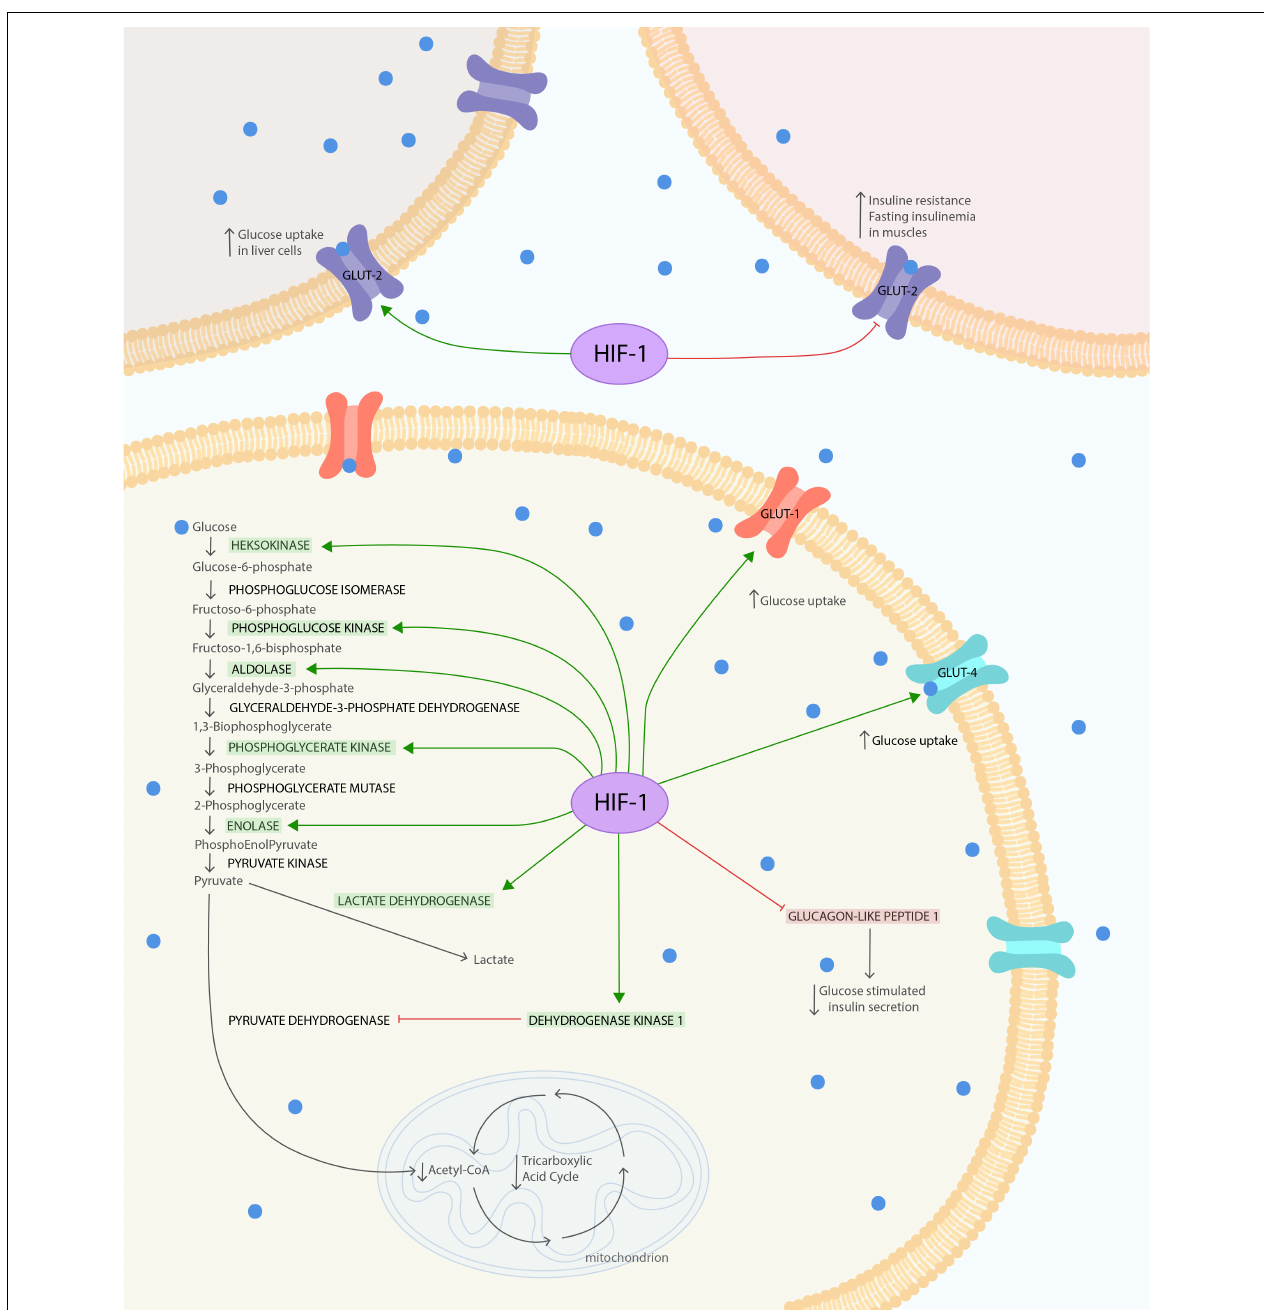
FIGURE 1 | HIF-1 α influence on glucose metabolism and insulin resistance. The HIF is composed of both oxygen-regulated α -subunit and constitutively expressed β -subunit. HIF-1 α protein is highly unstable under normoxia condition. Hypoxia leads to stabilization of HIF-1 α . HIF-1 α under hypoxic conditions causes several changes in glucose metabolism. It increases glucose uptake via glucose transporters GLUT-1 and GLUT-4 to cells. In the cell, glucose is used in glycolysis, which is also enhanced due to the modulated expression of glycolytic enzymes: phosphoglycerate kinase-1, hexokinase 1, hexokinase 2, aldolase A, enolase 1, and phosphofructokinase L. The final product of glycolysis—pyruvate—is mostly converted to lactate instead of acetyl-CoA, due to the increased lactate dehydrogenase A activity and pyruvate decarboxylation inhibition. Pyruvate dehydrogenase kinase 1 (PDK1) action leads to suppression of dehydrogenase complex (PDH) through its phosphorylation and thereby inhibits pyruvate decarboxylation. Secondary to the decreased levels of acetyl-CoA and the action of PDK1, the TAC is downregulated. At the same time, the increased expression of HIF-1 α reduces GLUT-2 phosphorylation and its expression in skeletal muscles. This leads to increased IR and fasting insulinemia after exposure to chronic hypoxia. To compensate for this metabolic imbalance, the expression of GLUT-2 in liver is increased. The glucose tolerance can also be impaired by upregulation of HIF-1 α , leading to GLP-1 downregulation, which causes reduction in glucose-stimulated insulin secretion via pancreatic β -cells. The Figure 1 was prepared in Adobe Illustrator (Adobe Inc., San Jose, CA, United States).